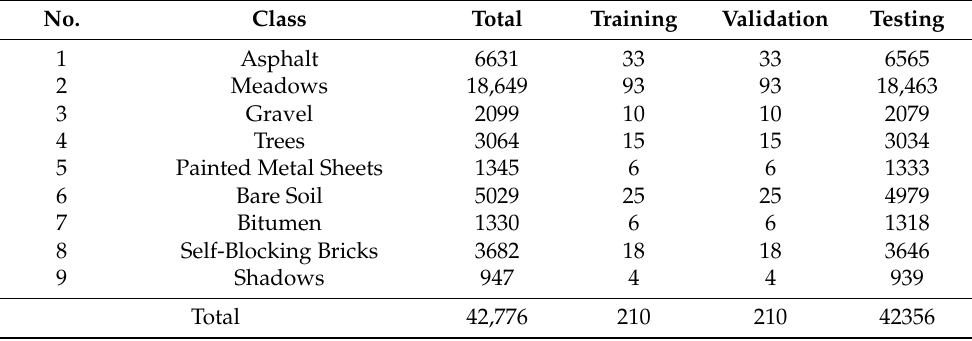
Table 1. Number of training, validation, and testing samples for the UP dataset.